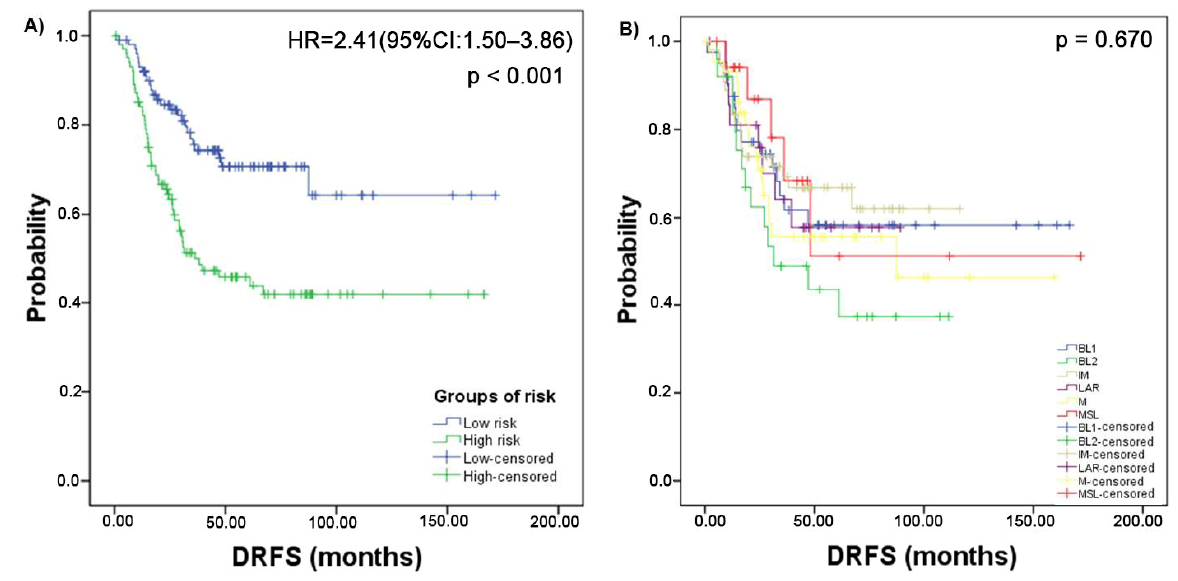
Figure 2. Survival curves of 204 Triple negative breast cancer (TNBC) patients. ( A ) Distant recurrence free survival (DRFS) of TNBC patients stratified by the 3-genes score using the median as cutoff. ( B ) DRFS for patients stratified by molecular TNBC subtype. Abbreviations: basal-like 1 (BL1), basal-like 2 (BL2), immunomodulatory (IM), mesenchymal (M), mesenchymal stem-like (MSL), and luminal androgen receptor (LAR).